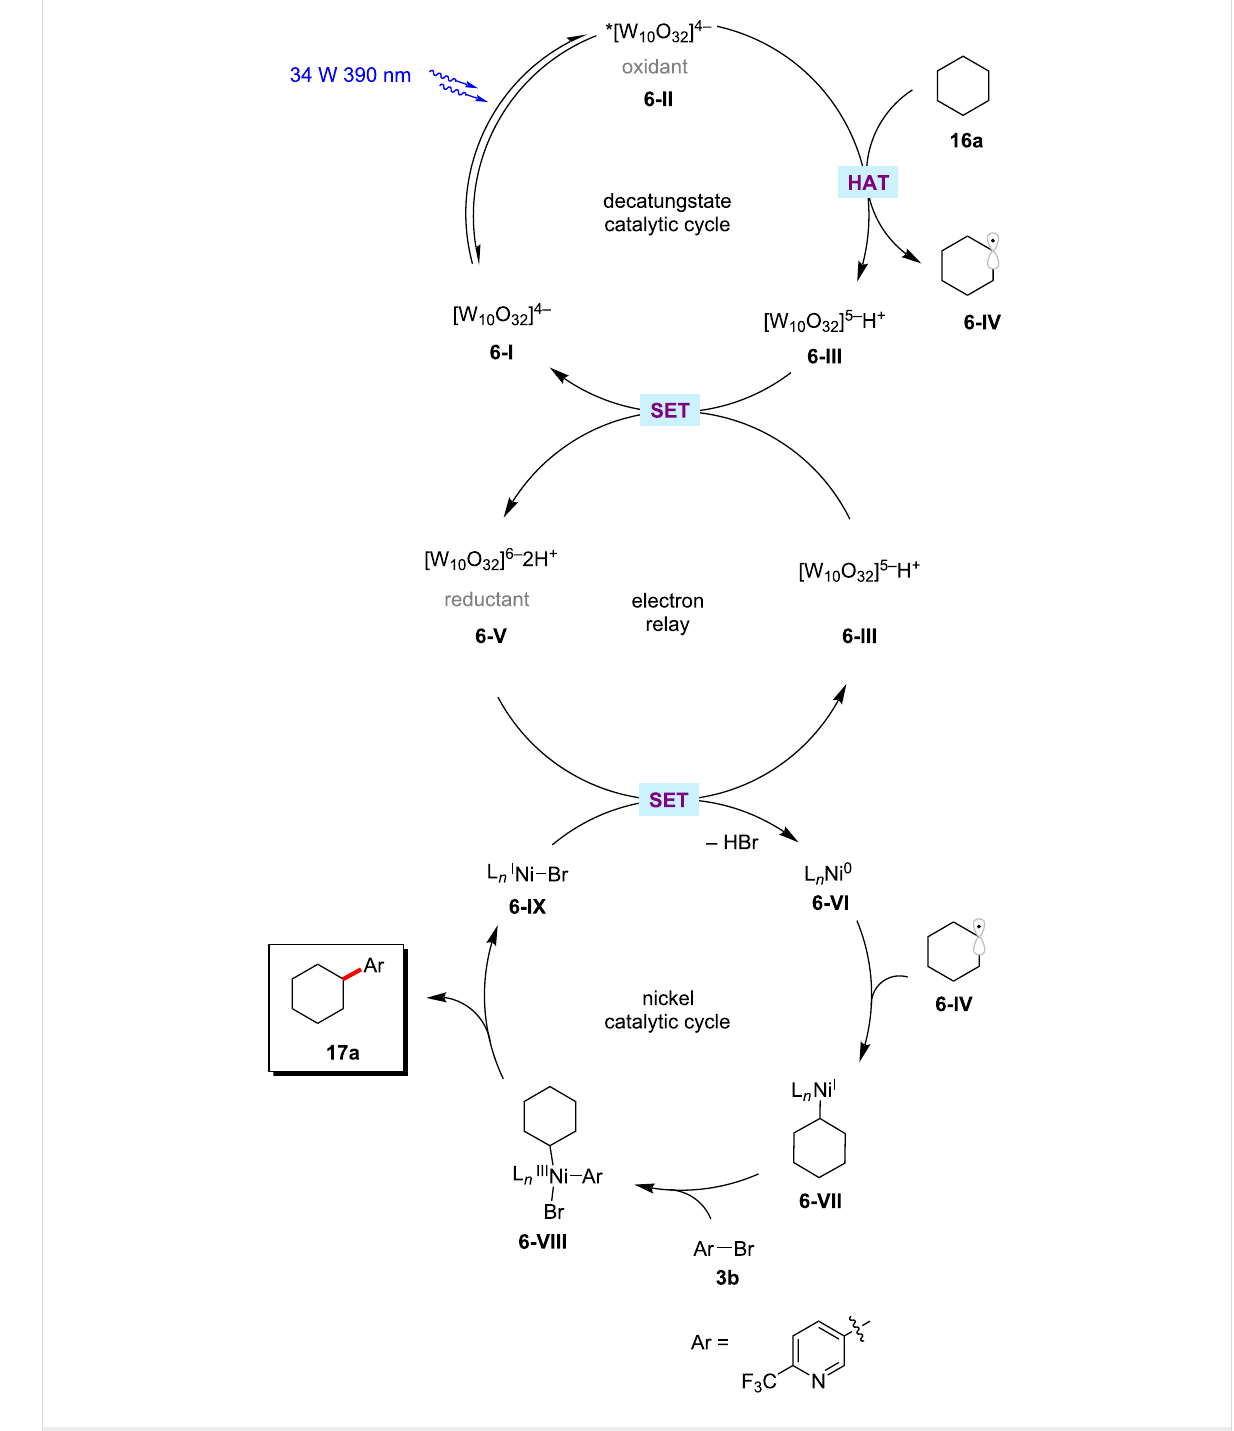
Figure 6: Proposed mechanism for C(sp 3 )–H arylation through dual polyoxometalate HAT and nickel catalytic manifold.